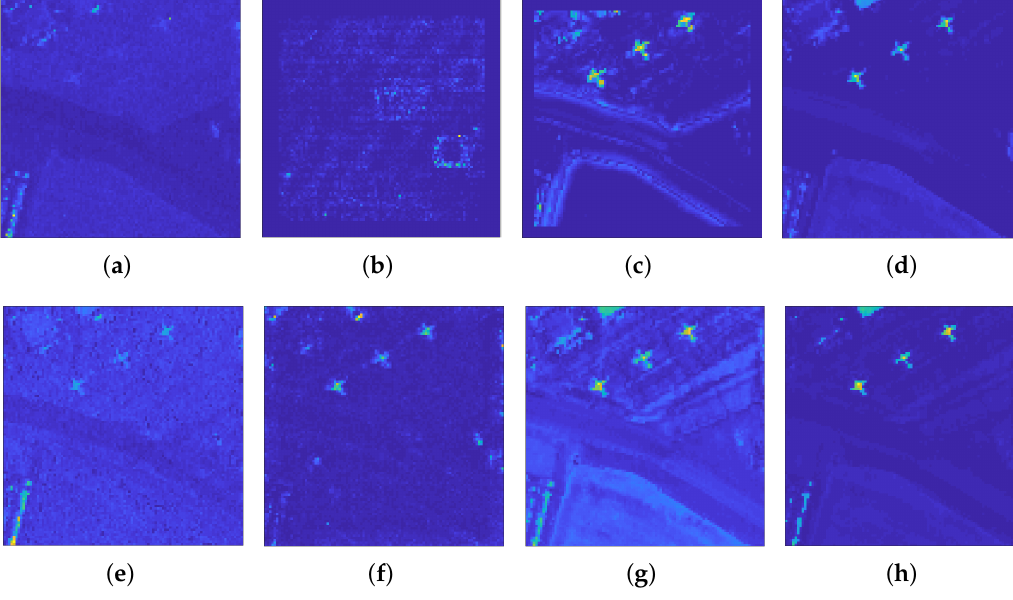
Figure 9. Two-dimensional maps of detection results by different algorithms for the AVIRIS–I